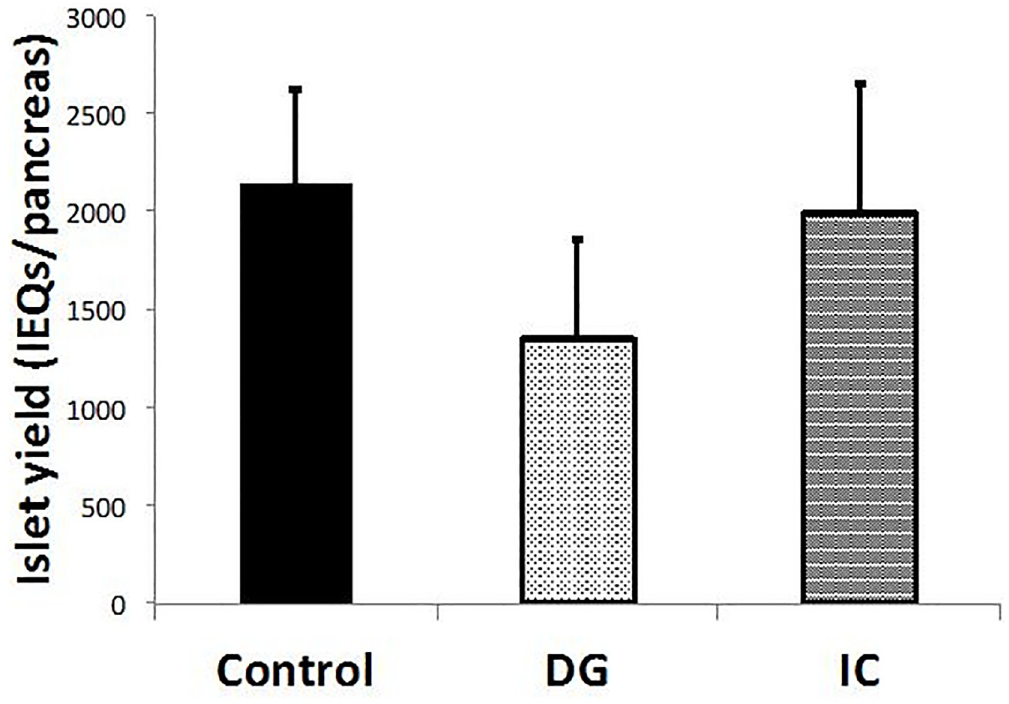
Fig 3. Influence of each dye on the yield of isolated rat islets. The islet yield after purification was considerably lower in the DG group compared with the Control and IC groups (n = 5). (Control: 0.01 ± 0.03, DG: 0.03 ± 0.04, and IC: 0.03 ± 0.02, n = 5) (Fig 4A), the ATP/DNA ratio (Control: 53.4 ± 8.1, DG: 54.0 ± 10.0, and IC: 47.2 ± 4.6 pmol/ μ g, n = 5) (Fig 4B), the stimulation index in the static glucose stimulation test (Control: 25.8 ± 16.0, DG: 22.9 ± 14.8, and IC: 23.4 ± 8.7, n = 5) (Fig 4C), or the insulin/DNA ratio (Control: 1.98 ± 0.43, DG: 1.86 ± 0.30, and IC: 1.94 ± 0.29 μ g/ μ g, n = 5) (Fig 4D).